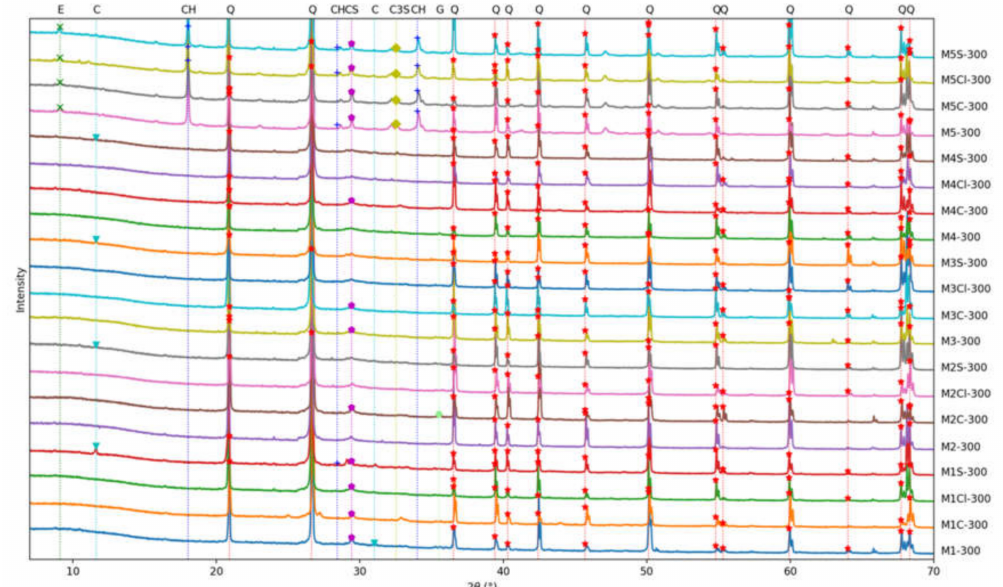
Figure 10. X-ray di ff raction (XRD) patterns of the five mixes in four curing conditions at 300 days. Q: Quartz; CH: Portlandite; E: Ettringite; C: Gypsum; CS: C 3 S / CaCO 3 / C-S-H; C3S: C3S; M: Mullite; G: